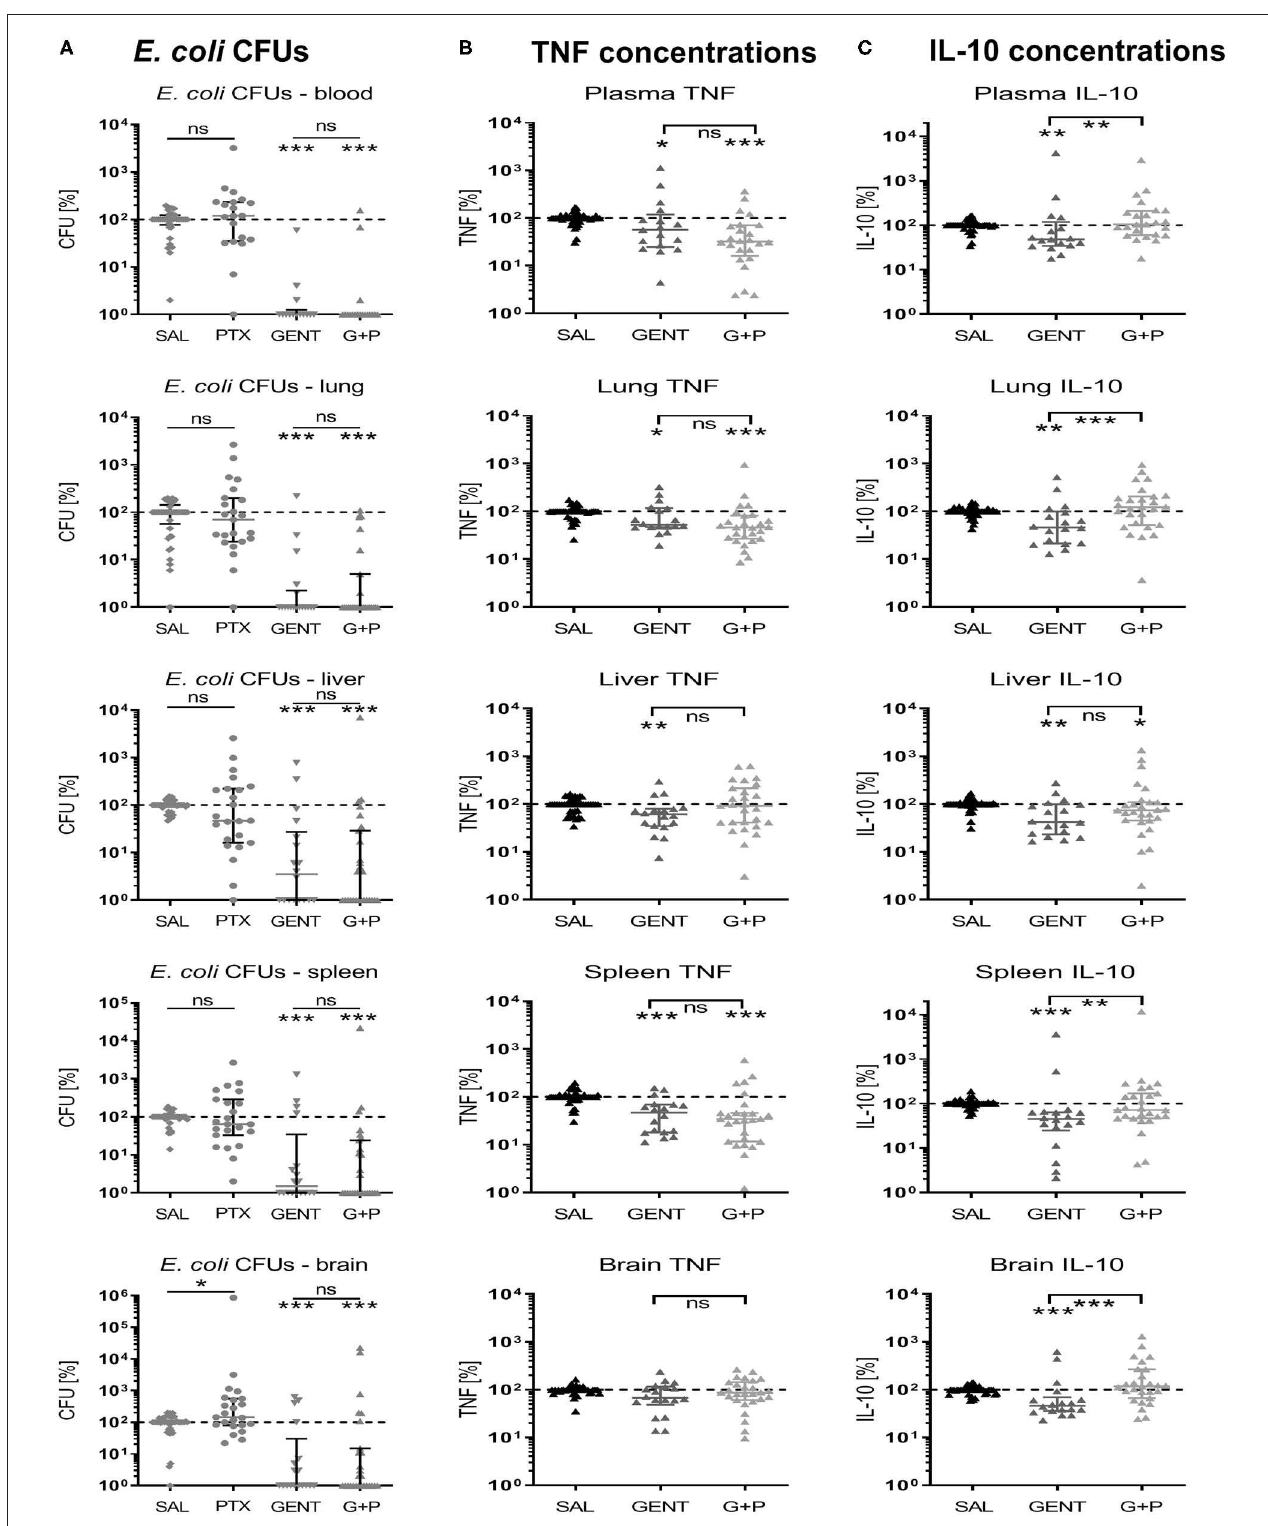
FIGURE 11 | Effect of GENT, PTX, and (GENT + PTX) on E. coli CFUs and cytokine production in neonatal mice relative to untreated septic mice. Neonatal mice < 24h old were injected IV with E. coli 10 5 CFU/g body weight, followed by 1.5h delayed IP injection of SAL, GENT, PTX, or GENT + PTX (G + P). After an additional 4h of incubation mice were euthanized, blood and homogenized organ tissues serially plated for bacterial counting, and cytokine concentrations measured. (A) CFU